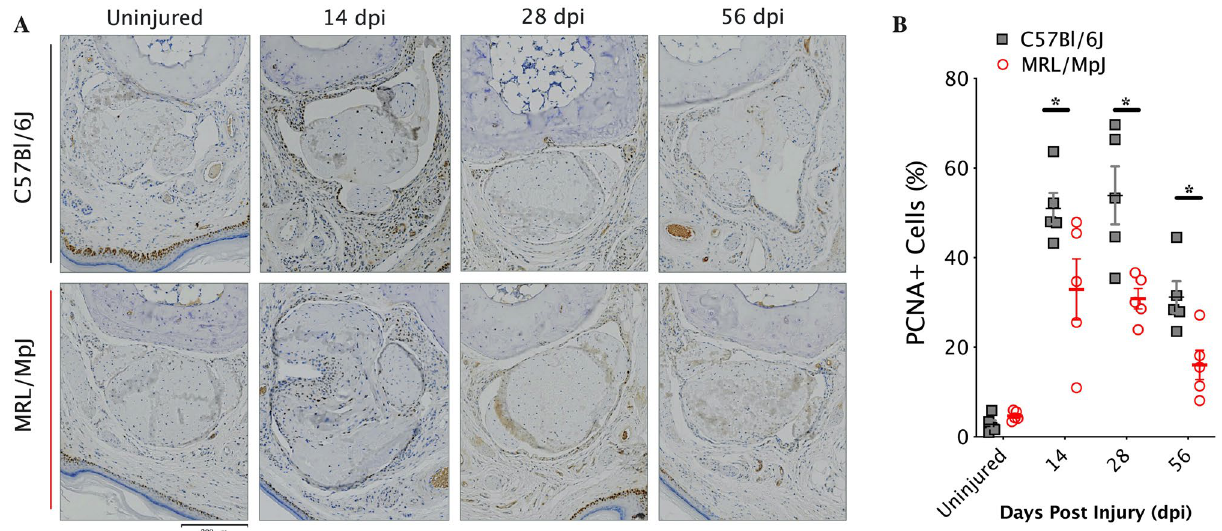
Figure 2. MRL flexor tendons heal with reduced cellular proliferation. ( A ) Representative images of proliferating cell nuclear antigen (PCNA) immunohistochemical (IHC) staining conducted before injury and over time post injury on 5 µm transverse paraffin sections and counterstained with hematoxylin, and then quantified ( B ) for percent PCNA-positive cells within the tendon and the surrounding peritendinous tissues (N = 5 per group, with n = 3–5 images (technical replicates) per animal). Scale bar = 200